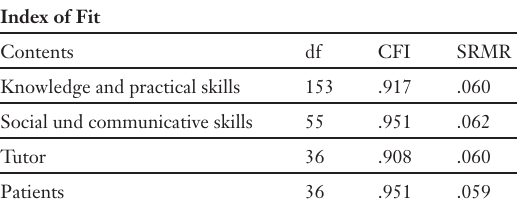
index of fit of the confirmatory factor analysis (CFA).The table shows the degree of freedom (df) of the computed CFA and the resulting goodness of fit indices for the four content parts of the questionnaire. A fit on the combined fit index is considered good when CFi (Comparative Fit index) >0.90 and SRMR (Standardized Root Mean Square Residual) <0.09 (see text for further